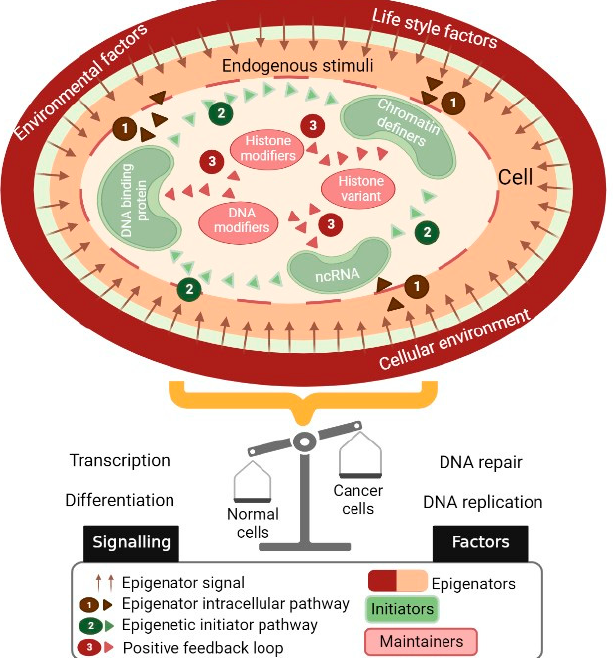
Figure 2. Influence of environmental factors on the establishment and maintenance of epigenetic states. The epigenators originate from the external environment of the cell, which activates specific signaling pathways. Epigenetic initiators respond to external signals that define the location of the epigenetic change within the chromatin. On the other hand, epigenetic maintainers support the epigenetic state of the chromatin. These modulators can dictate cellular outcomes by regulating key molecular processes including gene transcription, cell proliferation, and DNA repair, among others. Dysregulation of the epigenetic mechanisms by environmental and endogenous stressors may promote the development of abnormal phenotypes and